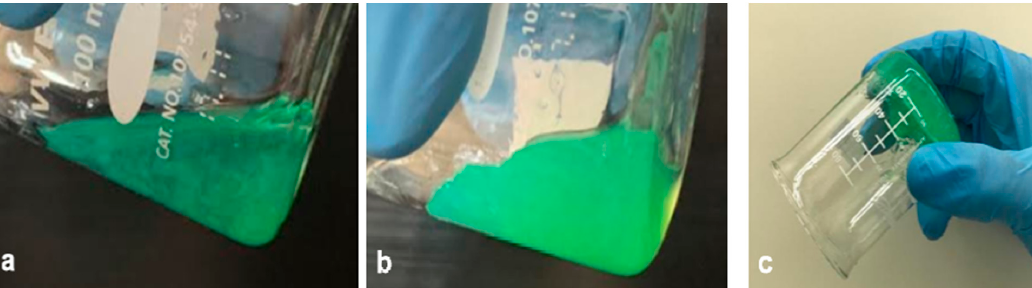
Figure 12. E ff ect of pH on the storage modulus of gels composed of 4% NiAc (9450 ppm Ni) / 9% PaM (T = 25 ◦ C). Energies 2020 , 13 , x FOR PEER REVIEW 12 of 16 Figure 12. Effect of pH on the storage modulus of gels composed of 4% NiAc (9450 ppm Ni)/9% PAM (T = 25°C).